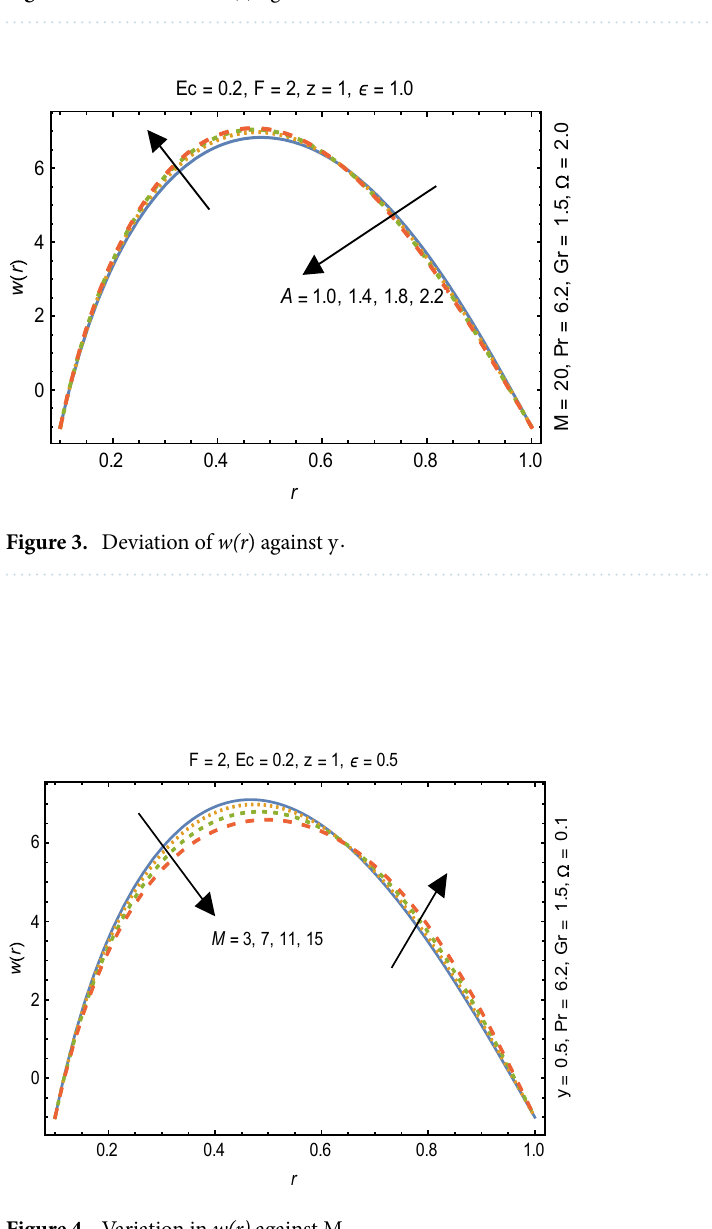
Figure 2. Deviation in w(r) against G r .